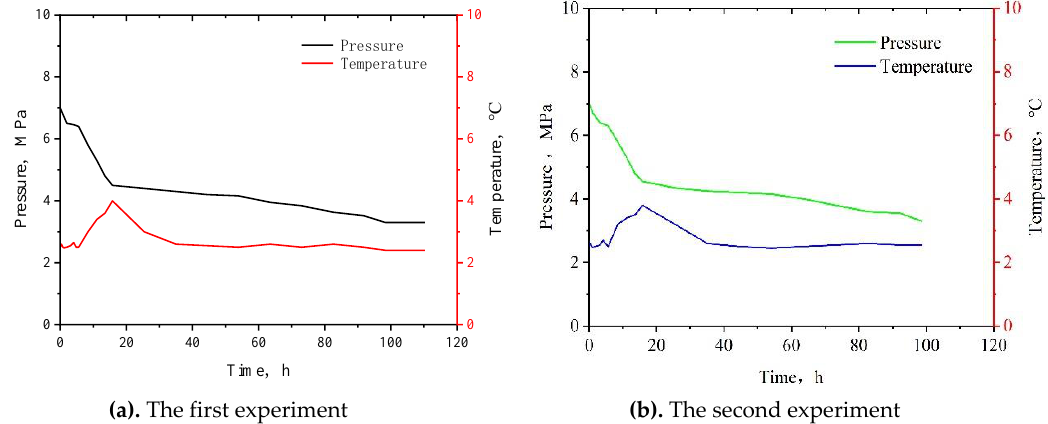
Figure 6. Resistivity changes during preparation of hydrate by stirring method.